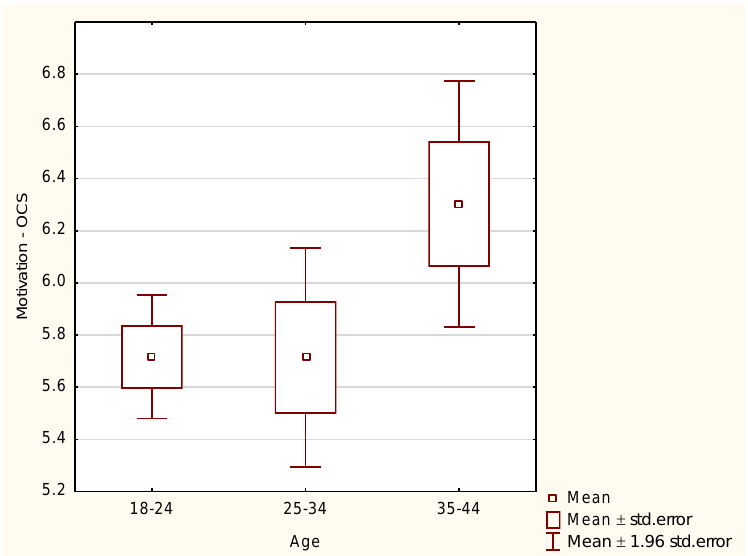
Figure 15. Own comfort and safety as a factor influencing the means of movement in different age groups.